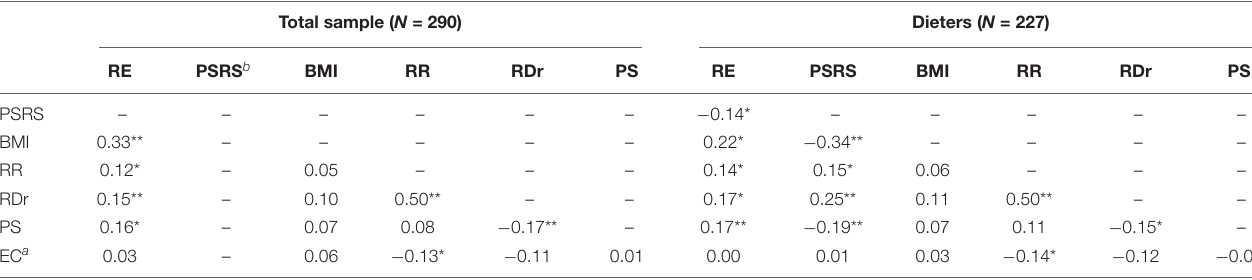
TABLE 2 | Bivariate correlations between all continuous variables.